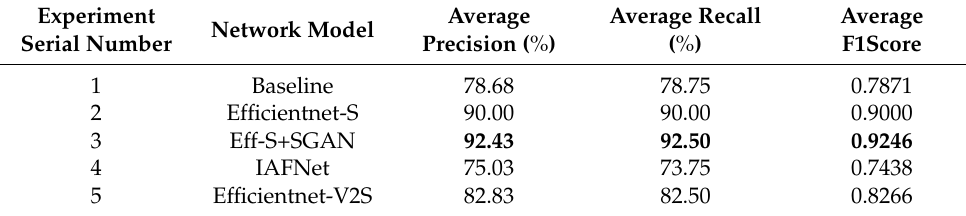
Table 6. The performance of the